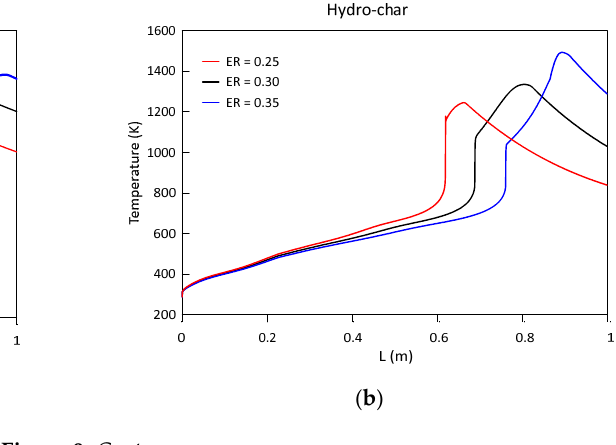
Olive Pomace Figure 9. Cont